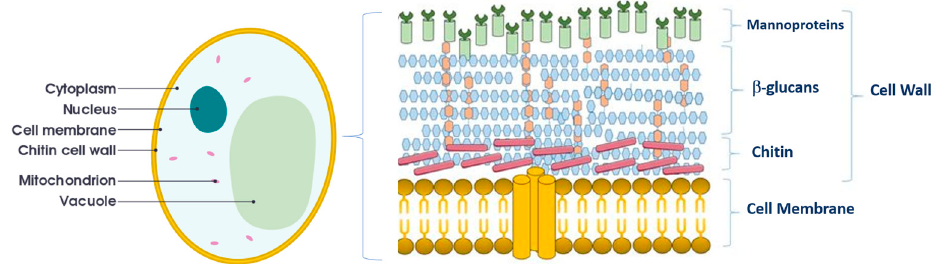
Figure 2. Constitution of yeast and yeast cell wall. Yeast β -glucans form long chains of a β -(1 → 3) linked glucan backbone with β -(1 → 6) linked glucose side branches Adapted from Anwar et al. [40].